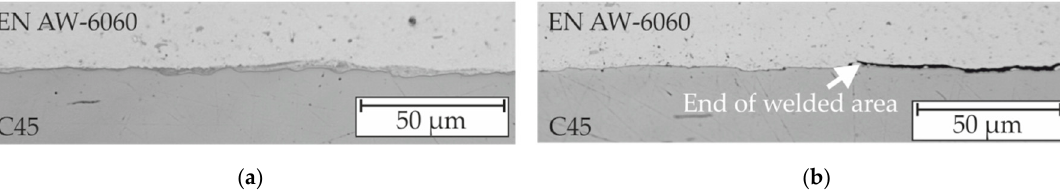
Figure 6. Polished cross section of the MPW sample joined with the EmGen setup ( g = 1.5 mm, E = 22.7 kJ, I max = 113 kA, Ø coil = 41 mm, w c = 15 mm, l w = 6 mm, welding direction from left to right, v i,r ≈ 250 m/s calculated according to [22] with measured flash appearance time equal to 12.6 µs): ( a ) in the middle and ( b ) at the end of the joining zone.